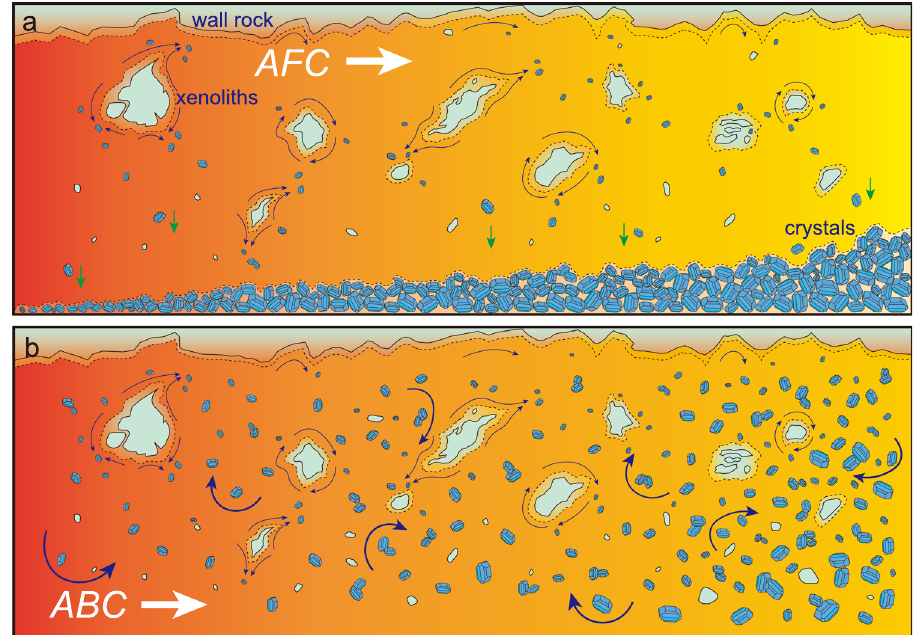
Fig. 1 Schematic illustration of temporal evolution of magmas from left to right. Bulk assimilation mostly occurs on the wallrock – magma boundaries via dissolution and/or from the crustal xenoliths induced by magmatic stoping. a Classical AFC model; heat for crustal assimilation is supplemented by concurrent fractional crystallization 8 while newly formed crystals are immediately sequestered from an almost entirely crystal-free liquid. b In the ABC model, during assimilation a steadily increasing amount of precipitated solids remains suspended by forced convection during magma fl ow and is continuously re-equilibrated with magma until it comes to rest and the solids are deposited all at